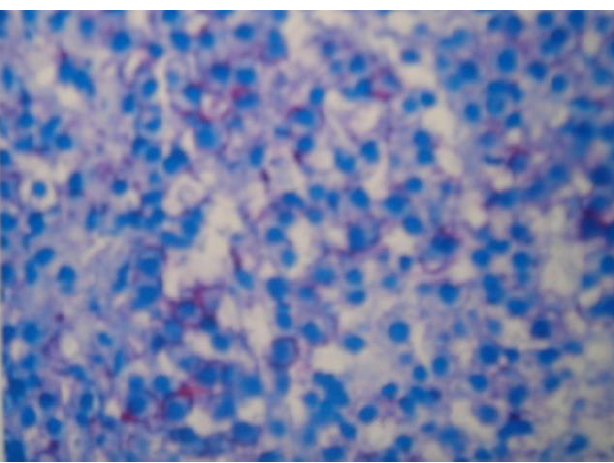
Fig. 6. Immunohistochemistry study, CD138(+)